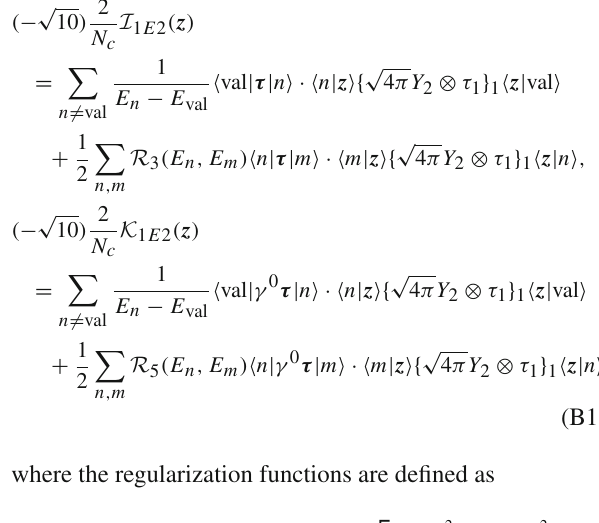
Table12 Therelevanttransitionmatrixelementsofthecollectiveoper- ators coming from the 35plet component of the baryon wave functions for the magnetic dipole form factors R